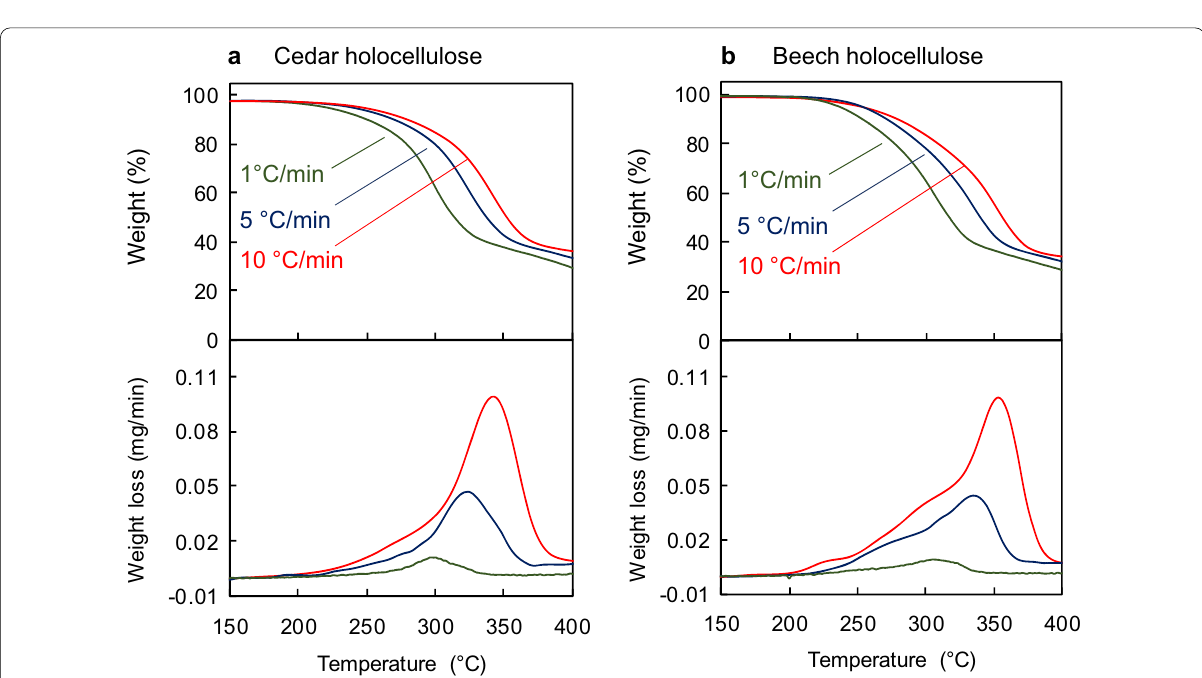
Fig. 8 TG/DTG curves measured for ( a ) cedar and ( b ) beech holocellulose samples at different heating rates of 1, 5, and 10